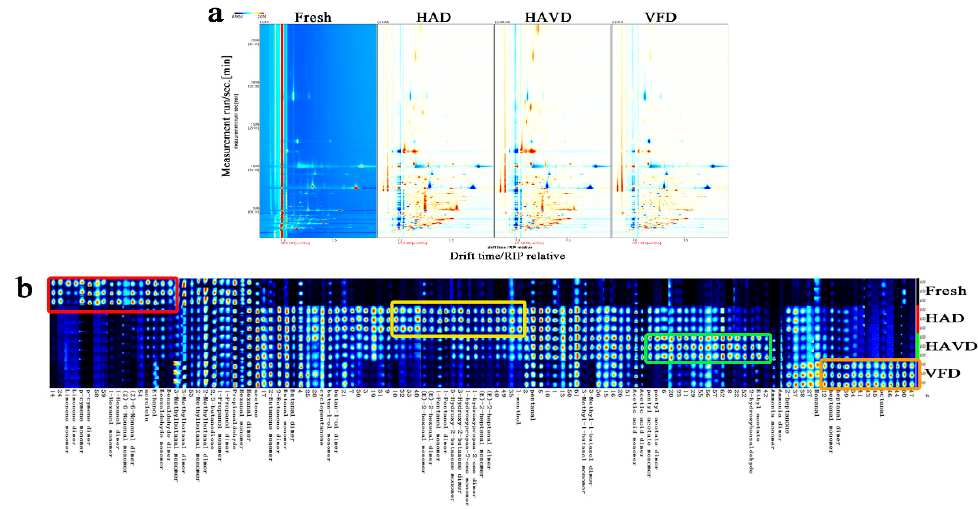
Figure 3. The fingerprints of the volatile flavor compounds of L. decastes under different drying methods, as determined by GC-IMS: ( a ) difference topographic plot, ( b ) gallery plot. HAD: hot-air-drying sample; HAVD: hot-air-combined-with-vacuum-drying sample; VFD: vacuum-freeze-drying sample.